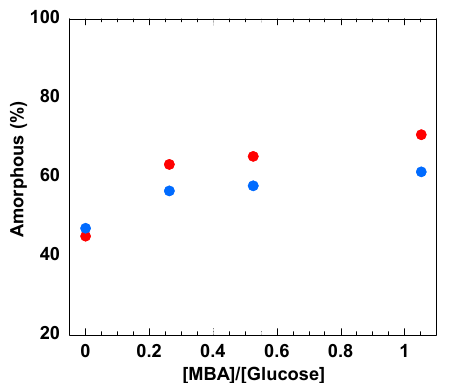
Figure 5. The percentages of amorphous cellulose in the hydrogels cured at 60 °C for 30 min (red symbols) and 23 °C for 12 h (blue symbols) estimated from Equation (2).